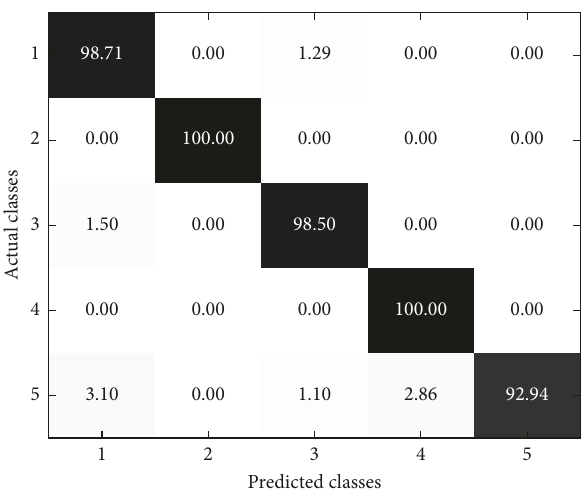
Figure 7: The confusion matrix (%) of MKSCDL on the SWIMCATdataset. The labels 1–5 refer to the corresponding cloud types: 1—clear sky, 2—patterned clouds, 3—thick dark clouds, 4—thick white clouds, and 5—veil clouds.